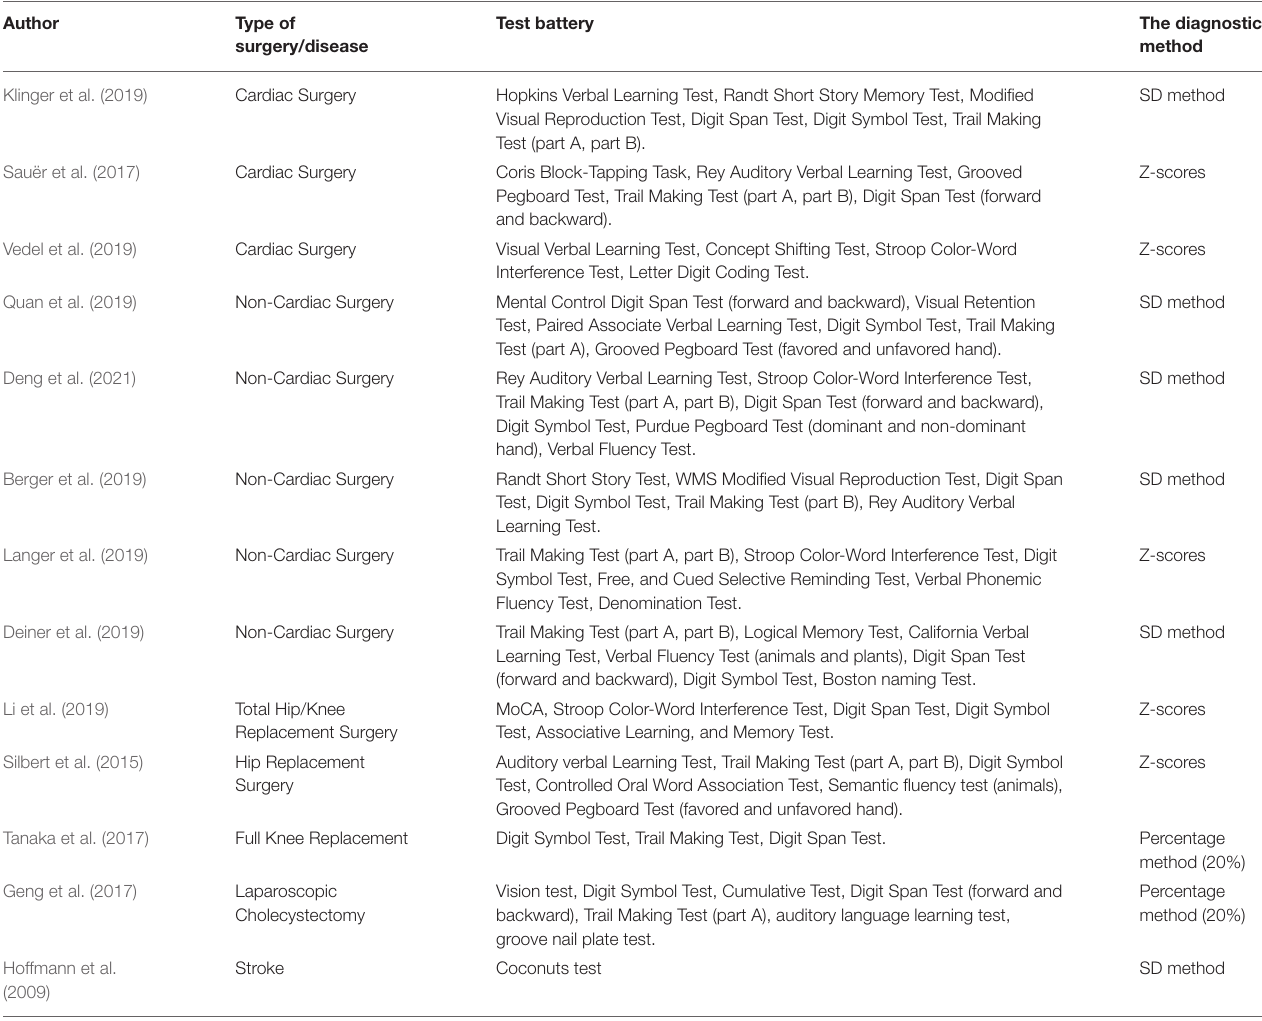
TABLE 1 | NPT batteries in clinical